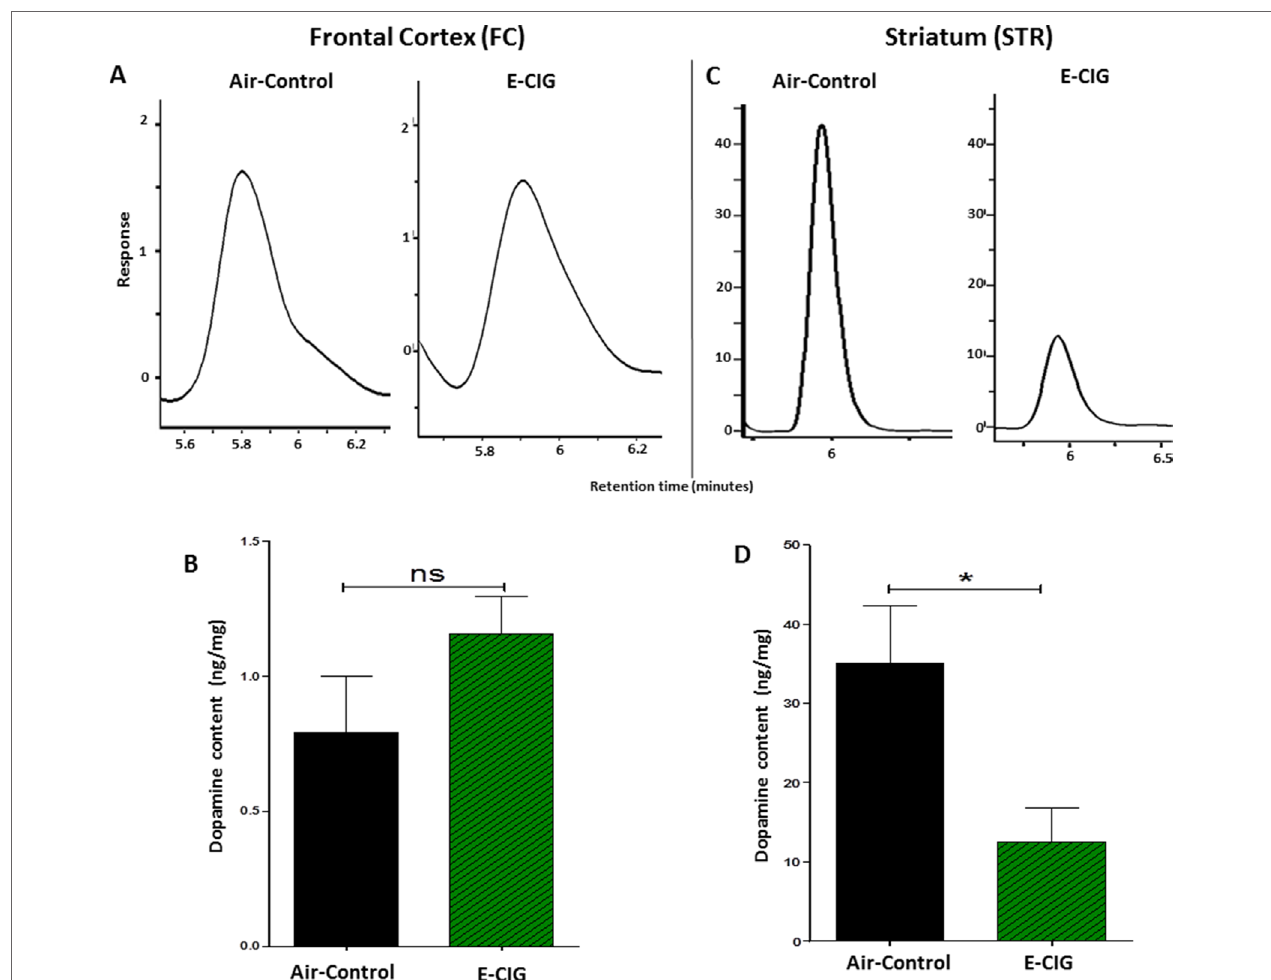
FIGURE 1 | Effects of inhalation of E-cigarette vapor (E-CIG) for 6 months on dopamine concentrations in the frontal cortex (FC) and striatum (STR) in male C57BL/6 mice. (A) Peaks of dopamine in the FC in air and E-CIG groups. (B) Independent t -test analysis did not show any significant alterations in dopamine concentration in the FC between control and E-CIG groups. (C) Peaks of dopamine in the STR for air and E-CIG groups. (D) Independent t -test analysis revealed a significant reduction in dopamine concentration in the STR in E-CIG vapor–exposed group as compared to air controls. Data are reported as mean ± SEM (* p < 0.05, ns; not significant), ( n = 5 for each group), ( X -axis, retention time [minutes], Y -axis,